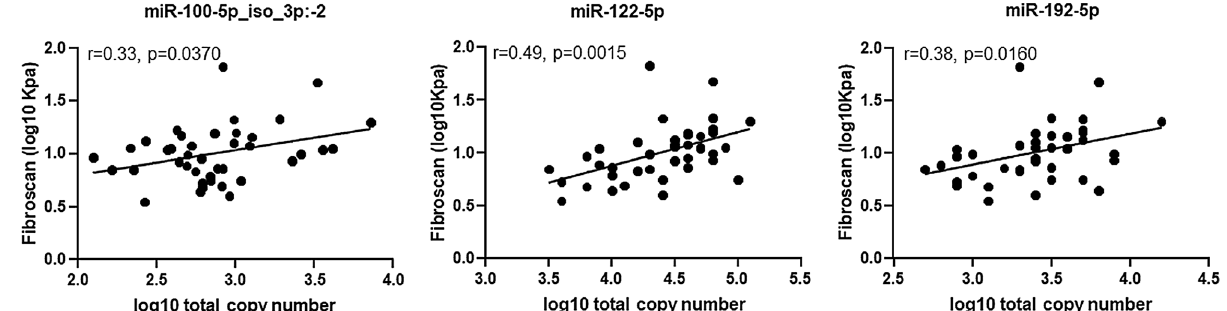
Figure 6. Pearson linear correlations between transient elastography liver fibrosis scores and RT-qPCR– determined plasma levels of miR-100-5p_iso_3p:−2, miR-122-5p, and miR-192-5p. Similar to the data obtained with high-throughput small RNA sequencing 15 , a significant association with liver fibrosis was also observed in this group of individuals with the data obtained using the RT-qPCR